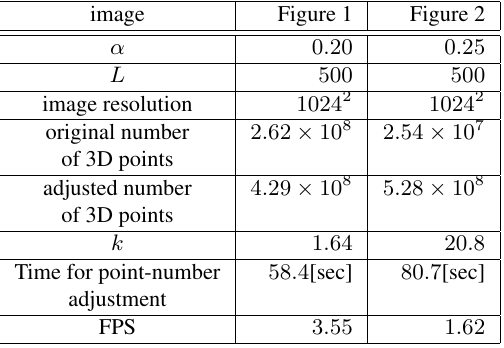
Table 1. Detailed computational data for the creation of Figures 1 and